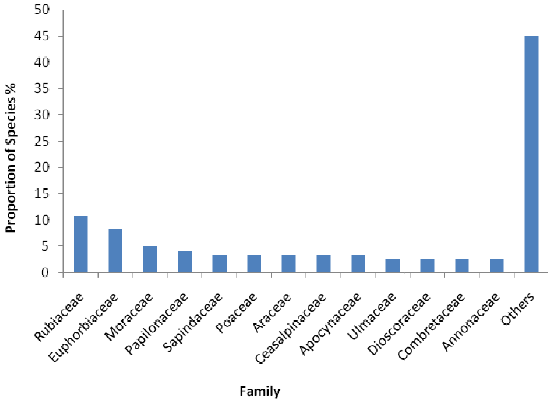
Fig. 3. Composition of plant species in the various life forms Composition of plant species in the various life forms identified in the study sites in Shasha forest reserve Shasha forest reserve